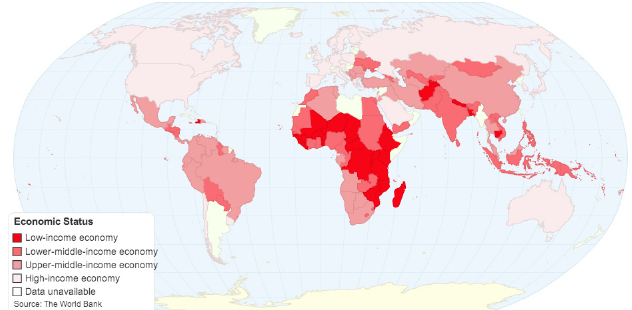
Figure 3. Map of Developing and Developed Countries (as determined by GNI per capita) elaborated according to the World Bank (2016), ChartsBin.com, viewed 25th September 2020, < http: // chartsbin.com / view / 25857 > .